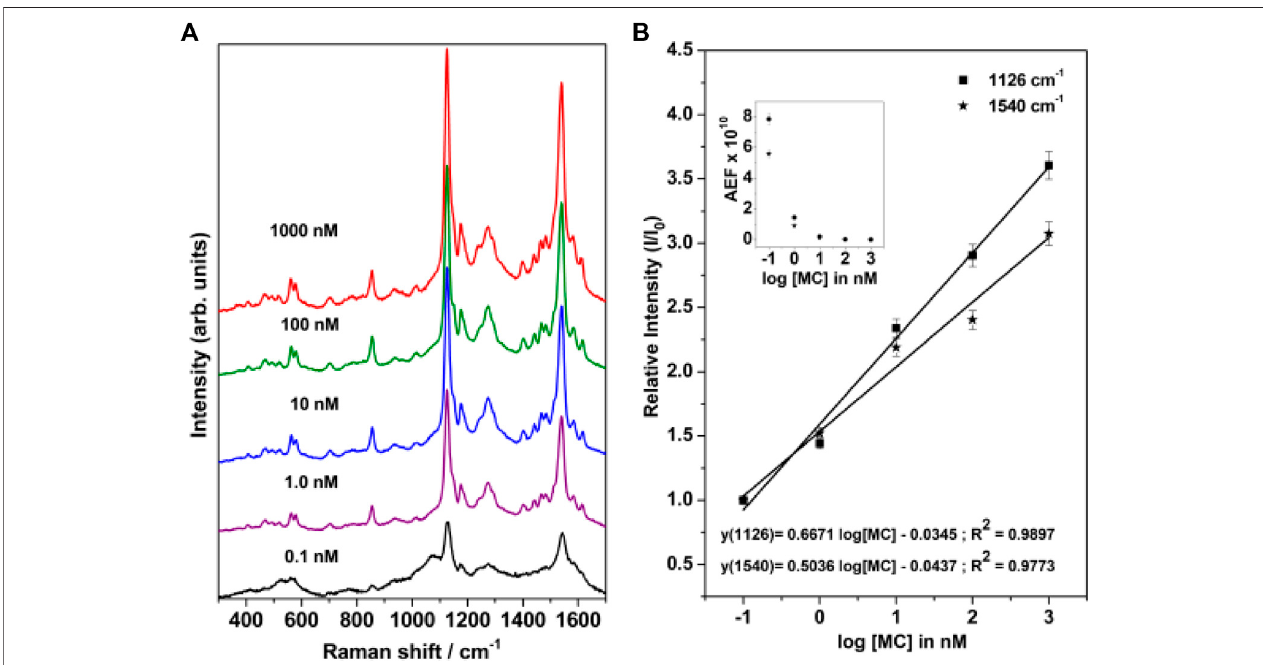
FIGURE 6 | (A) Concentration-dependent SERRS spectrum of merocyanine recorded at 514.5 nm excitation. (B) Relative SERRS intensity response (I/I 0 ) of the 1,126 and 1,540 cm − 1 bands of merocyanine as logarithmic function of the MC concentration. The inset in Figure 6B shows the analytical enhancement factor (AEF) corresponding to the 1,126 and 1,540 cm − 1 Raman bands as a function of merocyanine concentration.